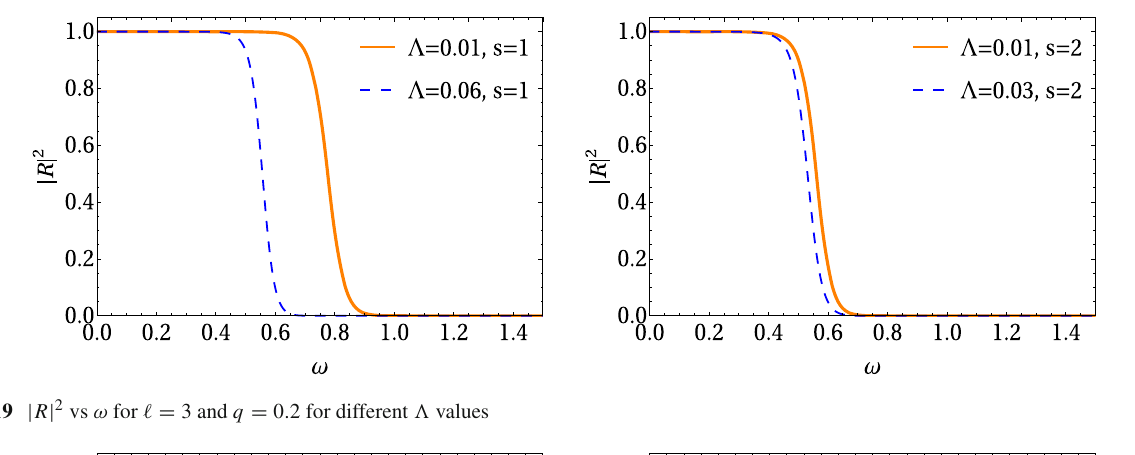
Fig. 18 | T | 2 vs ω with (cid:12) = 3 and (cid:2) = 0 . 02 for different magnetic charge ( q ) values